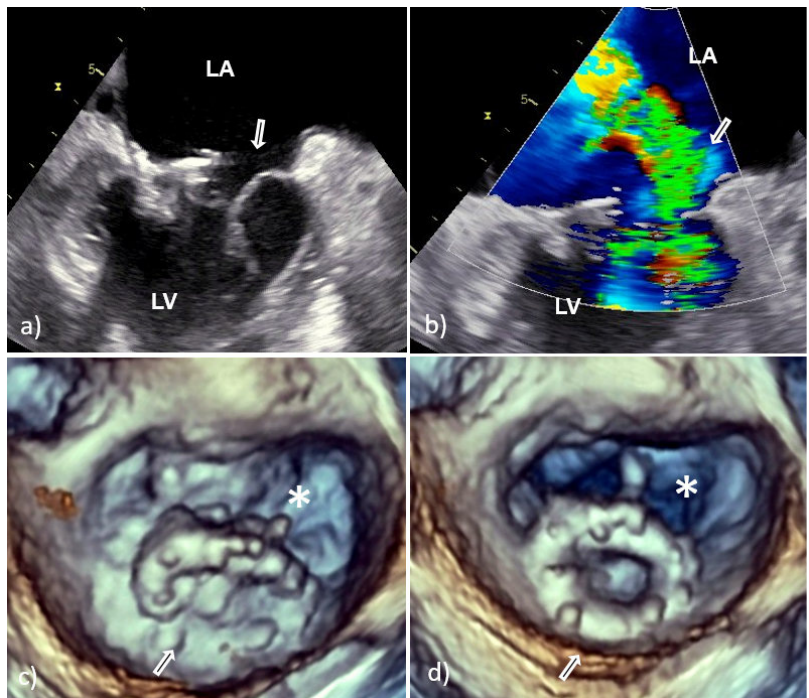
Figure 5. Transesophageal echocardiography of the mitral valve 15 days after surgical correction due to mitral valve prolapse. Two-dimensional TEE revealed dehiscence of the C-E ring with consequent severe regurgitation (white arrow, a , b ); 3D TEE showed almost complete dehiscence of the C-E ring which was attached to the native ring only on the smaller posterolateral segment (white arrow); the asterisk indicates the surface of the native mitral orifice ( c —in systole, d —in diastole). Clinical and laboratory parameters along with Staphylococcus epidermidis revealed in blood culture suggest that dehiscence was caused by infective endocarditis. 2D TEE—two-dimensional transesophageal echocardiography; 3D TEE—three-dimensional transesophageal echocardiography; C-E—Carpentier-Edwards ring; LA—left atrium; and LV—left ventricle.